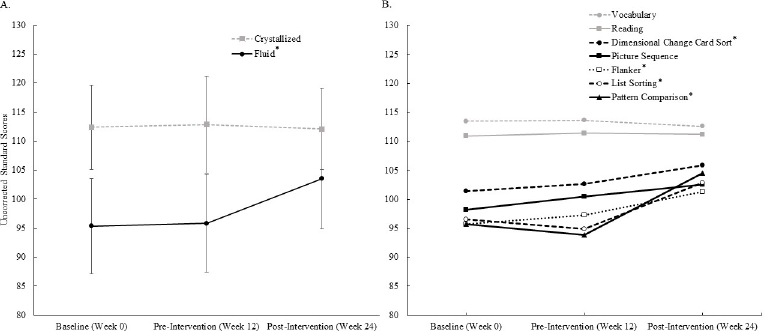
Fig 2. NIH Toolbox Cognition Battery uncorrected standard scores assessed at baseline, pre-intervention and post-intervention. A) Crystallized (N = 19) and fluid (N = 20) composite scores (Mean ± SD). B) Scores for each individual instrument (Means only, standard deviations were removed for simplicity). Crystallized composite scores and their corresponding instruments (Vocabulary and Reading) are shown in gray. Fluid composite scores and their corresponding instruments (Flanker, Dimensional Change Card Sort, List Sorting, Pattern Comparison, and Picture Sequence) are shown in black. � p < 0.05.